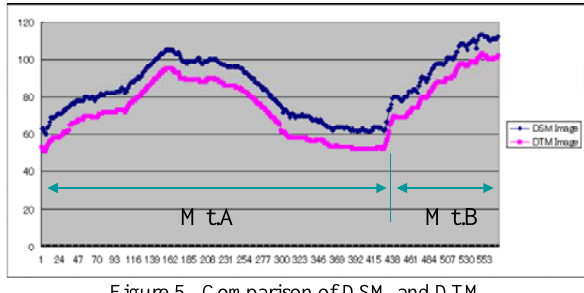
Figure 5. Comparison of DSM and DTM